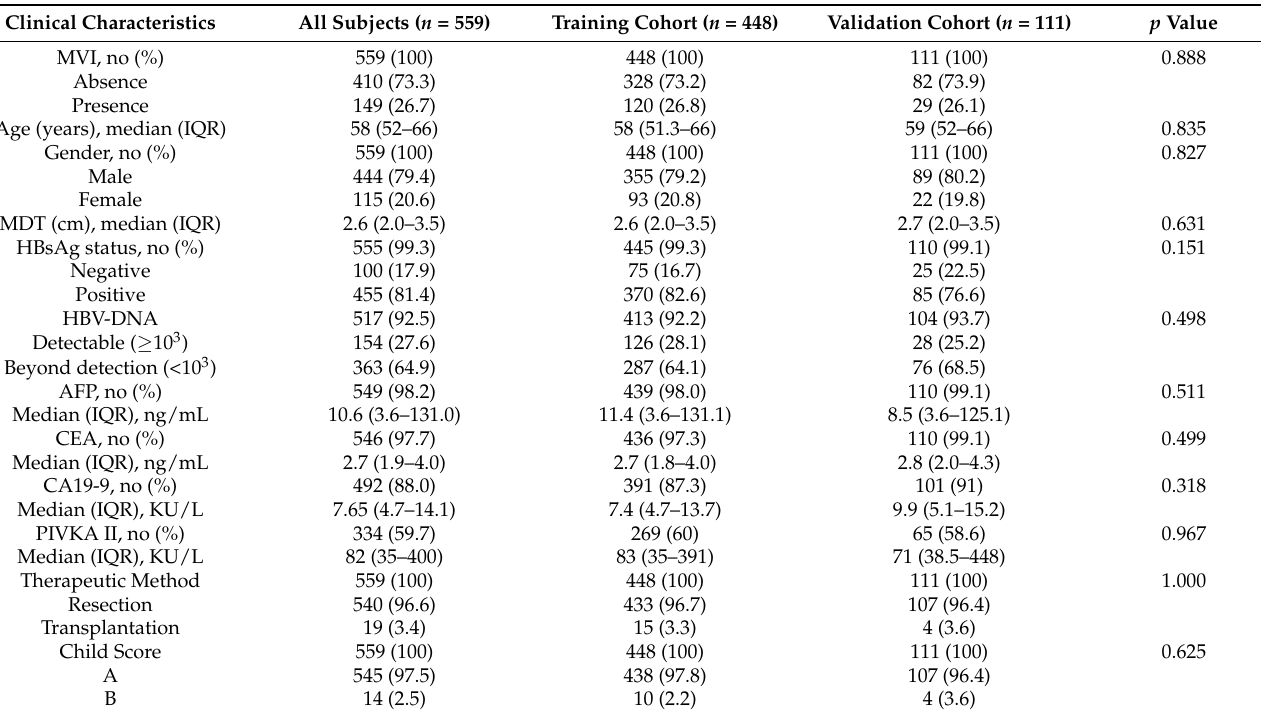
Figure 3. The workflow of this study. The workflow of our work included tumor segmentation, data augmentation, features extraction, model construction, and performance evaluation. Table 1. Demographic characteristics of patients in the training and validation cohorts.